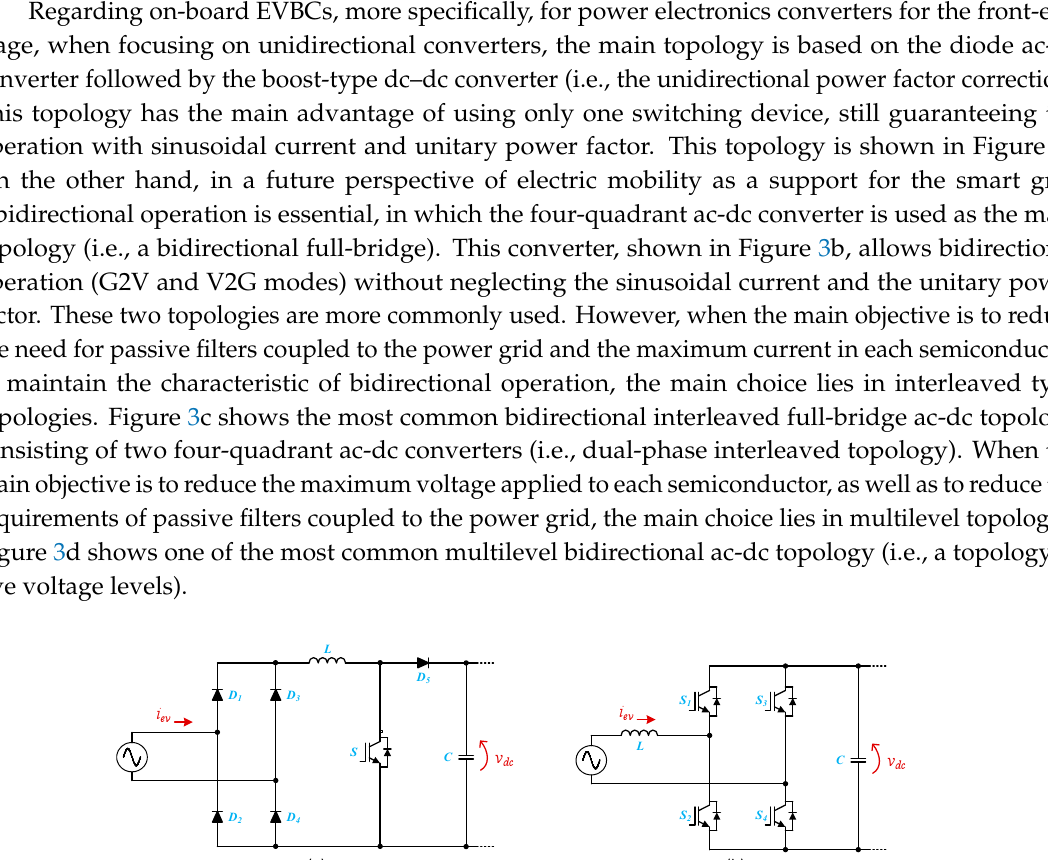
Figure 2. EV considering both on-board and off-board battery chargers and the respective interface with the electrical power grid, allowing bidirectional power flow and communication.